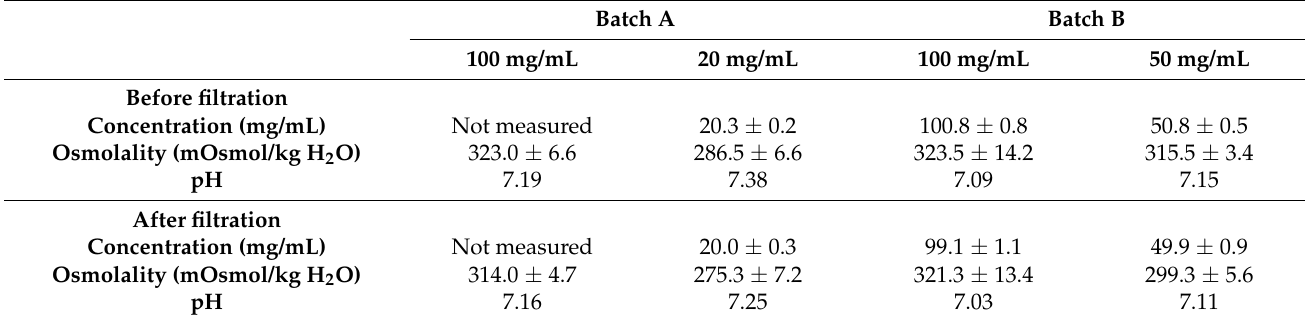
Table 1. Drug concentration, osmolality, and pH of HCQS solutions before and after filtration. Batch